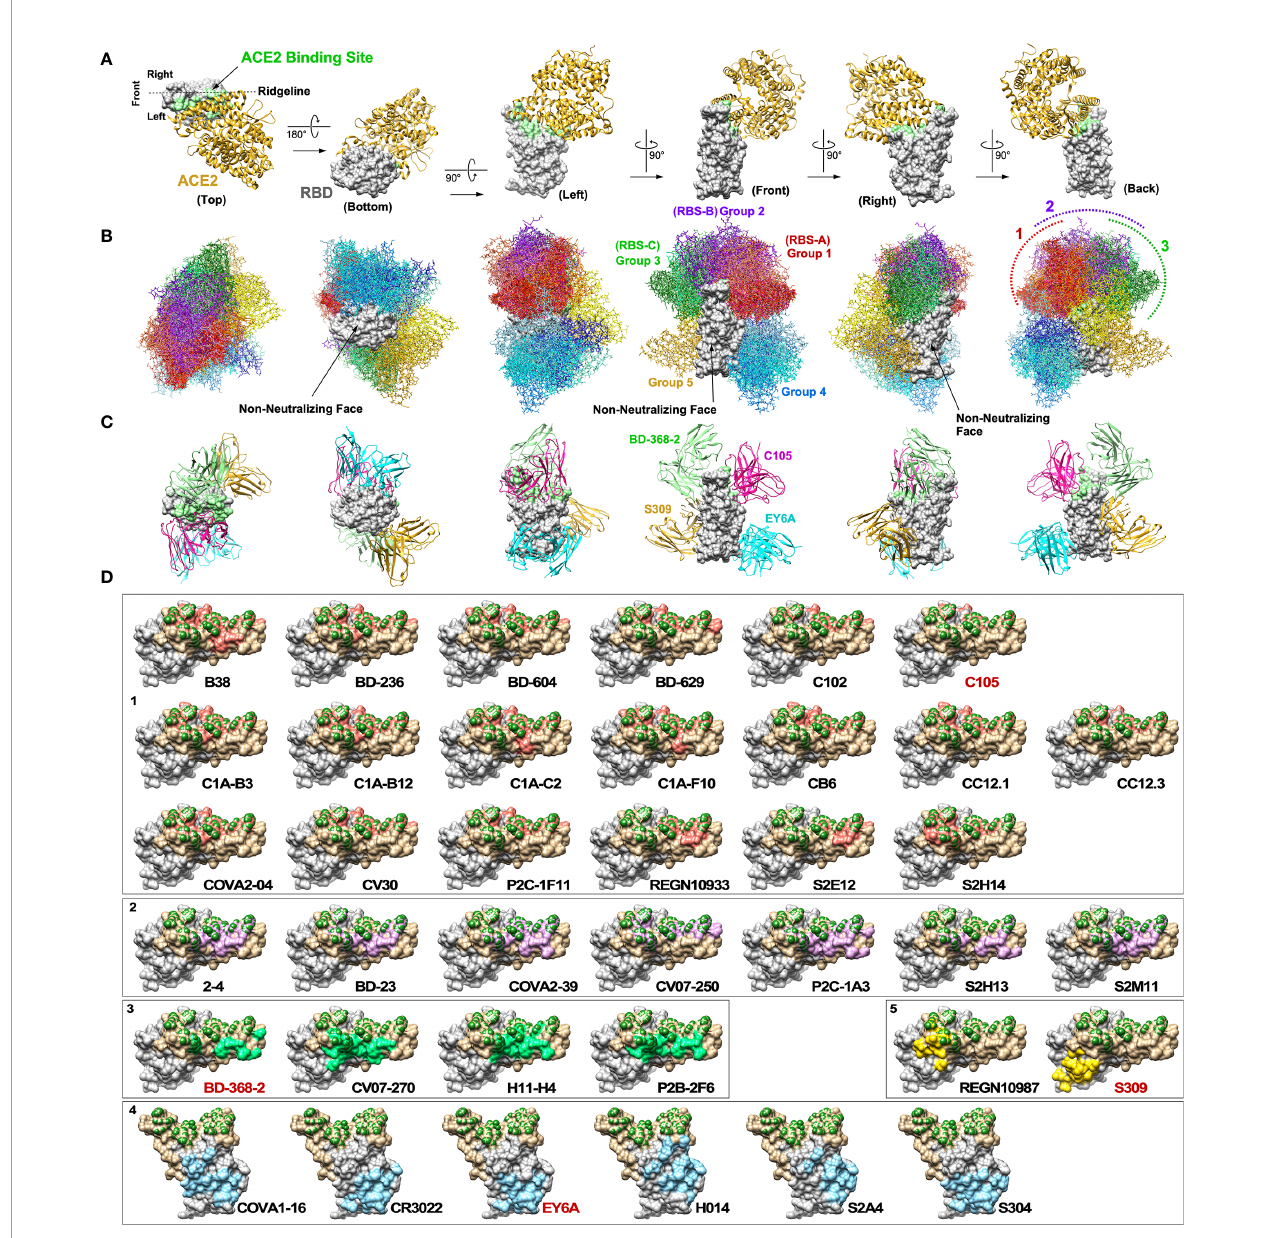
FIGURE 2 | Neutralizing antibodies against SARS-CoV-2 RBD. (A) A cocrystal structure of the RBD (grey) bound to ACE2 (gold) is shown in six orientations (PDB: 6M0J). ACE2 binding site is highlighted in light green. (B) Structures of 38 nAbs were superimposed onto the RBD. Five groups of nAbs are shown in different color tones (1: red, 2: purple, 3: green, 4: blue and 5: yellow). Three non-neutralizing faces are indicated. (C) Maximum of up to four nAbs could potentially bind the RBD simultaneously. (D) Footprints of individual nAbs are shown. To generate footprints, “ Clashes/Contacts ” tool in UCSF Chimera was used to identify residues on RBD that contact nAbs. Default contact criteria of VDW overlap ≥ -0.4 Å was used. ACE2 contact residues are shown in dark green. Footprints are colored as for panel (B)